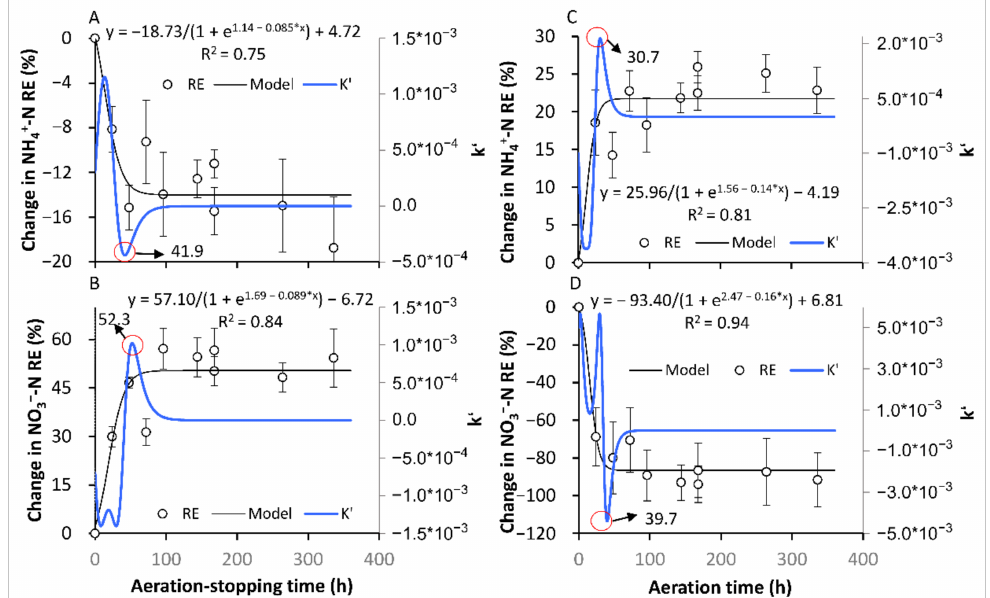
Figure 5. The formation processes of the new stable states in the removal efficiencies of NH 4 + -N and NO 3 − -N after the transformation from aeration to no aeration. ( A , B ) show the formation of SS-AN NH4+ and SS-AN NO3 − , respectively, in the AE-D reactors; ( C , D ) show the formation of SS-AE NH4+ and SS-AE NO3 − , respectively, in the AN-D reactors. The red circle is the position of the inflection point, and the number indicated by the arrow is the corresponding time of the inflection point. (sample